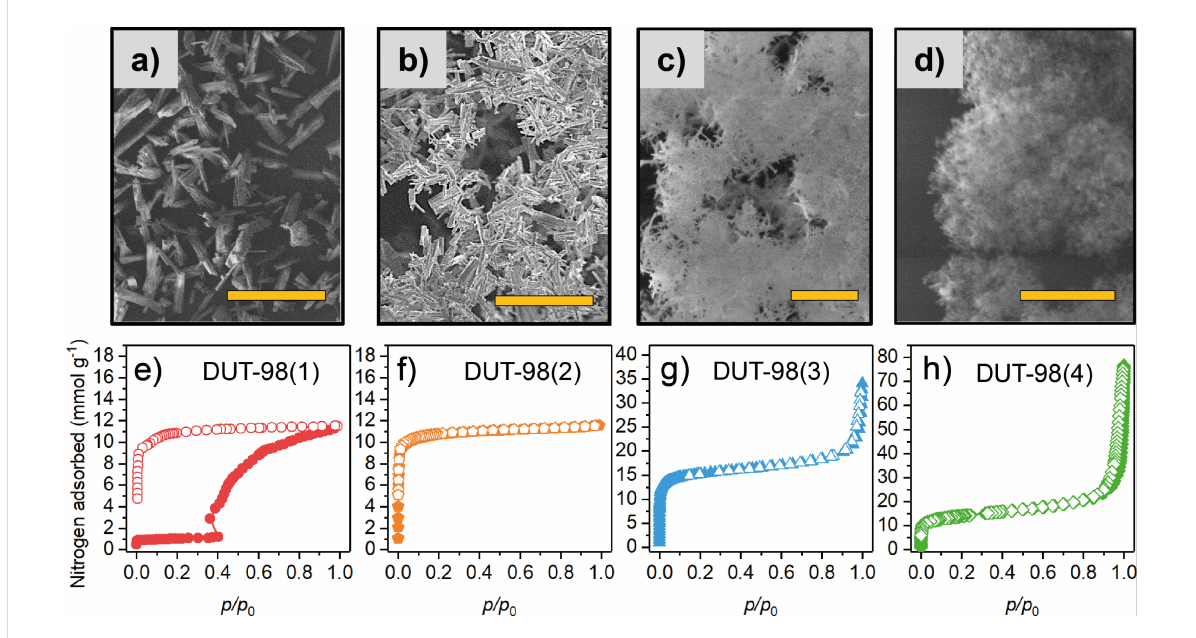
Figure 3: a–d) SEM images and e–h) nitrogen adsorption–desorption isotherms at 77 K for samples DUT-98(1) (a,e), DUT-98(2) (b,f), DUT-98(3) (c,g), and DUT-98(4) (d,h). Scale bars: a) 200 µm, b) 50 µm, c) 1 µm, and d) 500 nm. Closed symbols: adsorption, open symbols: desorp- tion.